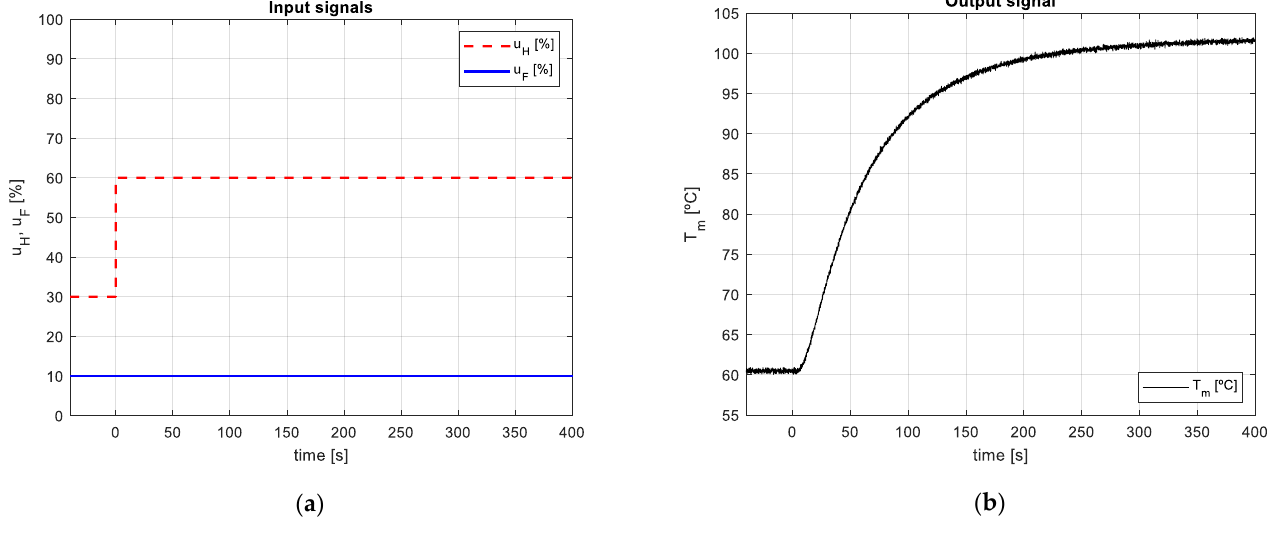
Figure 28. Experimental open-loop step test for determining FFOPDT model parameters: ( a ) Control signal u H (t) [%] and command signal to air fan u F (t) [%]; ( b ) Process reaction curve T m (t) [°C] ob- tained from an open-loop step-test experiment.